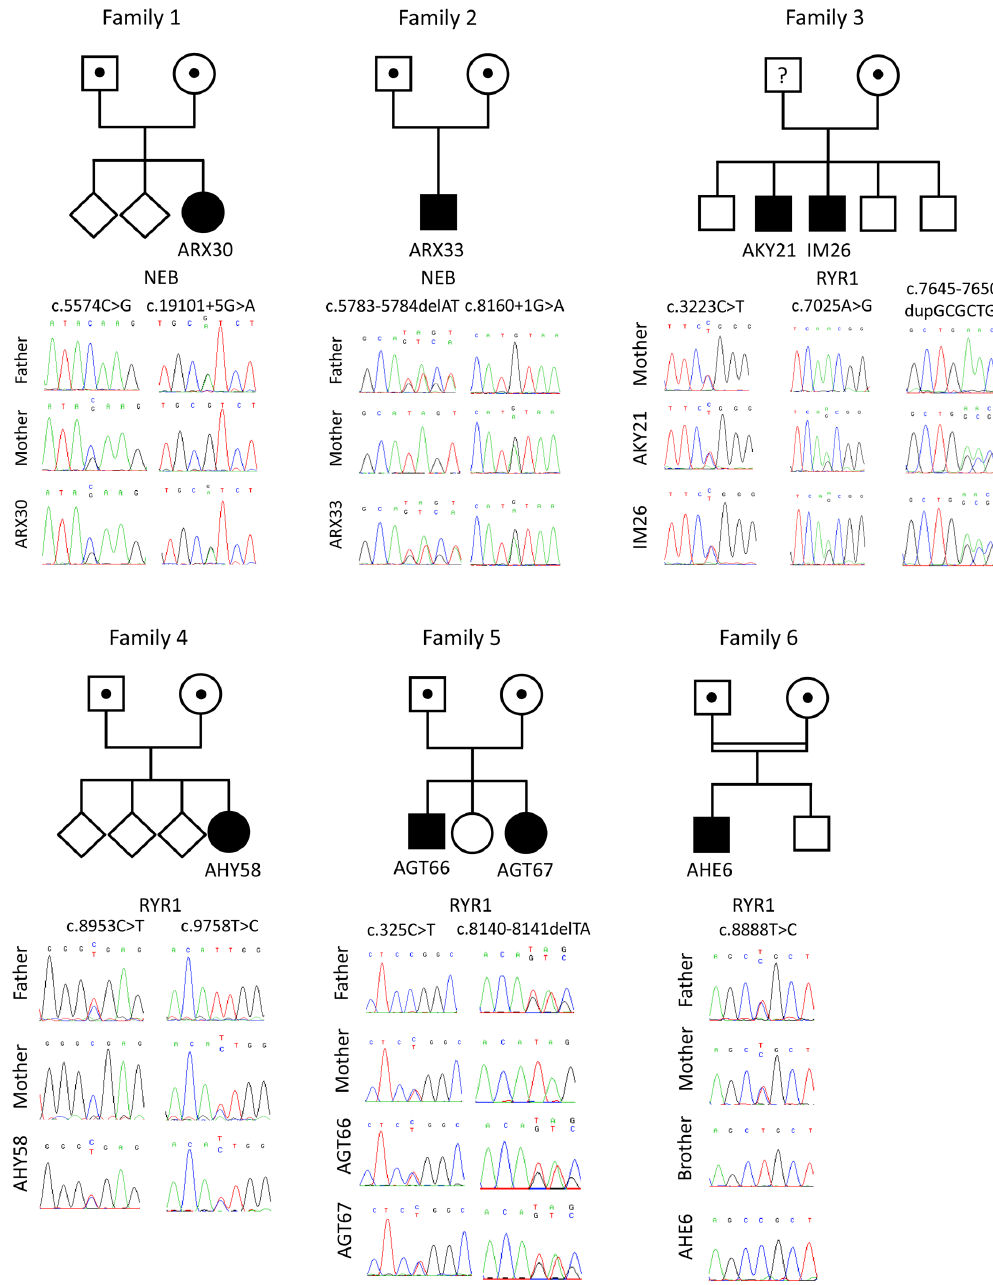
Figure 1. Pedigrees and RYR1/NEB mutations in six families with different muscle disorders. Patient ARX30 harbors the NEB c.5574C . G mutation on the maternal and the NEB c.19101 + 5G . A mutation on the paternal allele. Patient ARX33 harbors the NEB c.8160 + 1G . A mutation on the maternal and the NEB c.5783_5784delAT mutation on the paternal allele. Patients AKY21 and IM26 carry the heterozygous c.3223C . T, c.7025A . G and c.7645-7650dupGCGCTG mutations in RYR1 . The c.3223C . T mutation was found on the maternal allele, the father’s DNA was not available. AHY58 harbors two heterozygous RYR1 mutations: c.8953C . T on the paternal allele and c.9758T . C on the maternal allele. In patients AGT66 and AGT67 we identified the heterozygous RYR1 mutations c.325C . T on the maternal and c.8140_8141delTA on the paternal allele. Patient AHE6 from a consanguineous family was found to harbor the homozygous RYR1 c.8888T . C mutation, both parents were heterozygous.